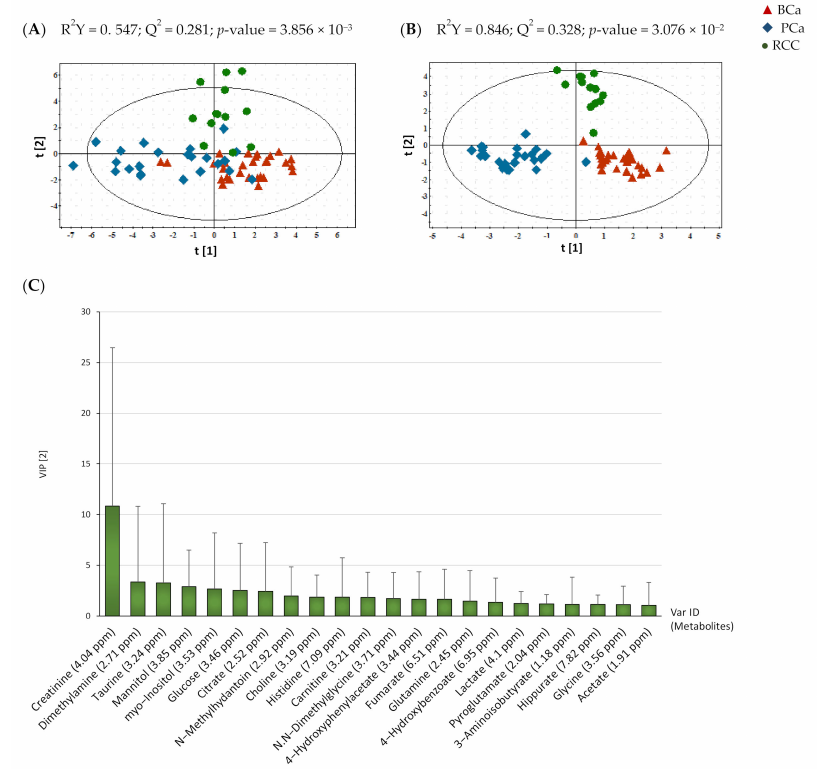
Figure 2. Metabolic multivariate pattern recognition analysis. ( A ) PLS-DA score plots from the 1 H NMR spectra with water suppression from patients with urological cancers: BCa ( n = 29, (cid:78) red); PCa ( n = 24, (cid:117) , blue); RCC ( n = 12, • , green); ( B ) OPLS-DA score plots based 1 H NMR spectra of urinary metabolites among cancer groups. All the score plots were assessed by R 2 Y, Q 2 , and p CV-ANOVA ( p < 0.05); ( C ) VIP score plot represents the variables with VIP value higher than 1 selected in the OPLS-DA model. Var ID indicates each contributing